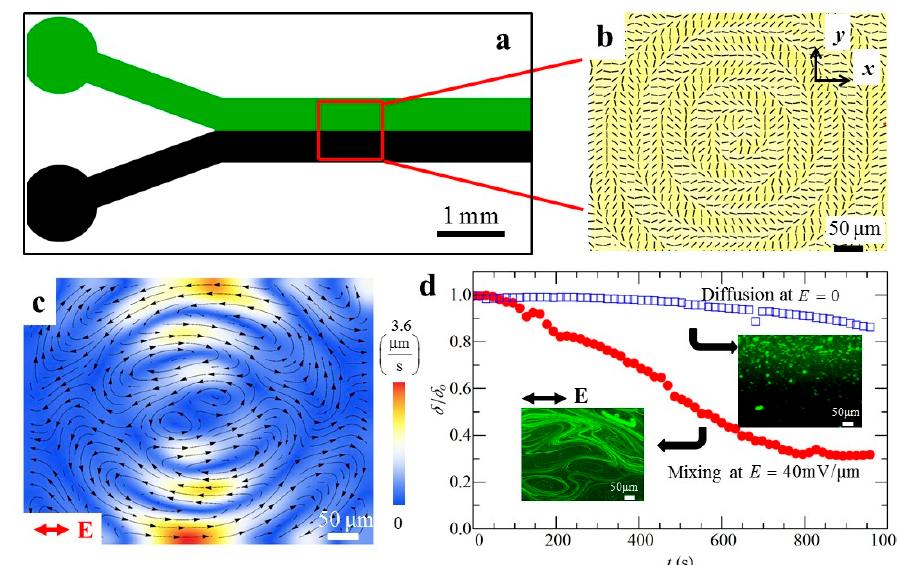
Figure 13. Micro-mixing in a Y-junction microfluidic device with photo-patterned director distortions demonstrated by Peng et al. [26]. ( a ) Y-junction with a photo-imprinted mixing pad (red square) that combines the LC with fluorescent particles (green) and pure LC (black); ( b ) PolScope texture of the mixing pad; ( c ) Velocity maps within the mixing pad caused by an AC electric field; ( d ) Comparison of mixing efficiencies of passive diffusion and LCEK. Adapted with permission from [26].